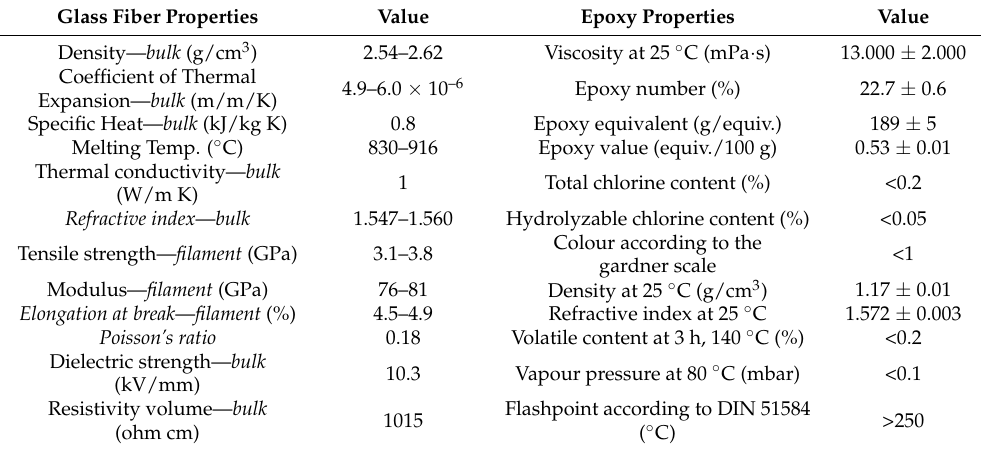
Table 1. Properties of glass fiber and epoxy.